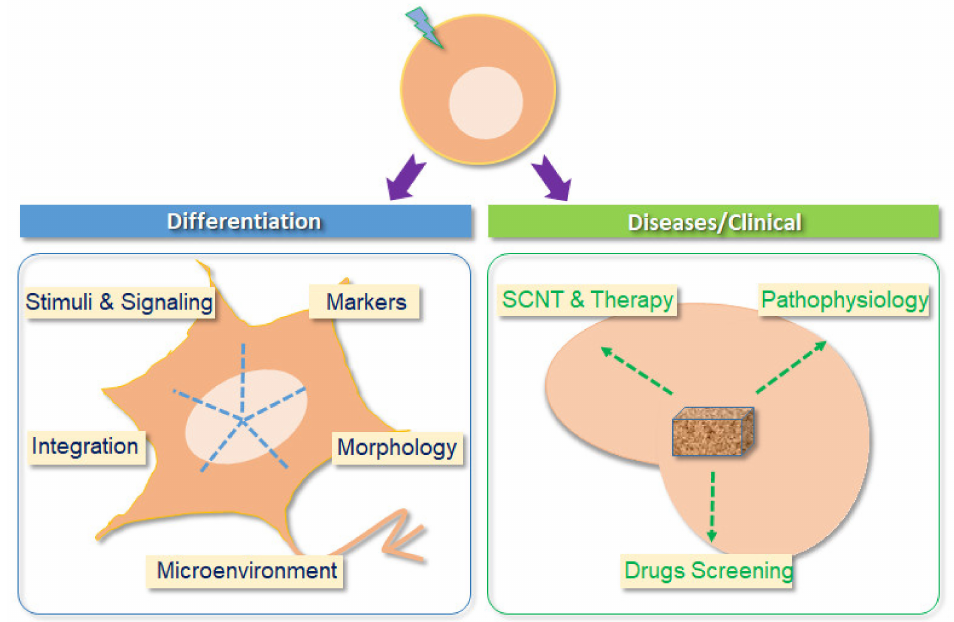
Figure 2. Two major aspects of the application of glutamatergic neurons have been differentiated from ESCs. One is to investigate the differentiation process. Both structure and function can be conveniently studied in this context. The other aspect, which is more difficult, is to develop personalized and precision medicine approaches so that this eventually becomes a practical approach to treating patients. Furthermore, using glutamatergic neurons derived from human and/or mouse ESCs, disease mechanisms and high throughput/content drug screening can be easily performed in vitro. Thus, glutamatergic neurons might one day be used as replacements to repair impaired neurons/tissues in patients. SCNT, somatic cell nuclear